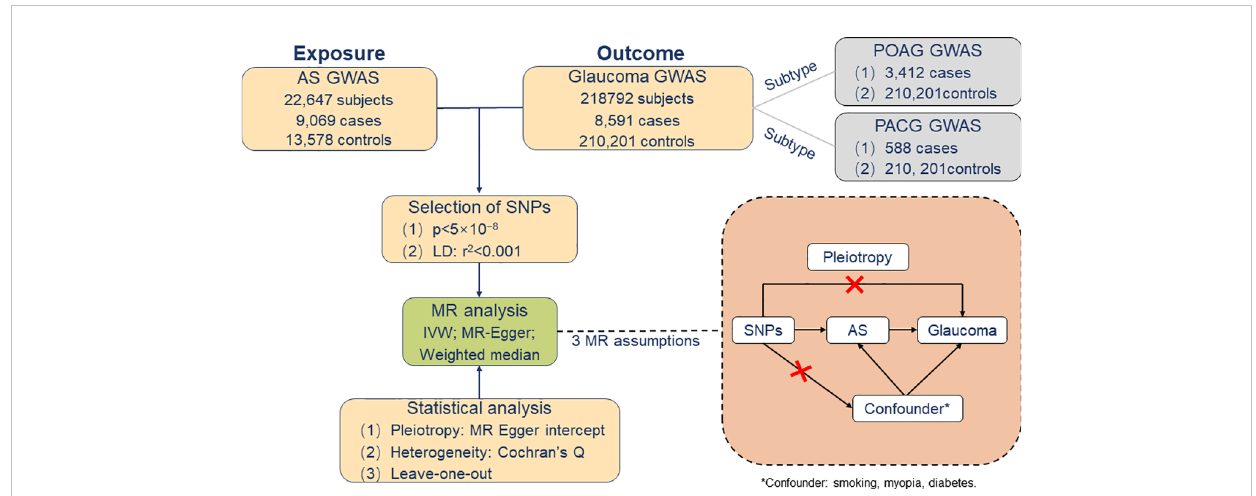
FIGURE 1 Overview of Mendelian randomization analysis and major assumptions. AS, ankylosing spondylitis; GWASs, genome-wide association studies; POAG, primary open-angle glaucoma; PACG, primary angle-closure glaucoma; *Confounder: smoking, myopia,